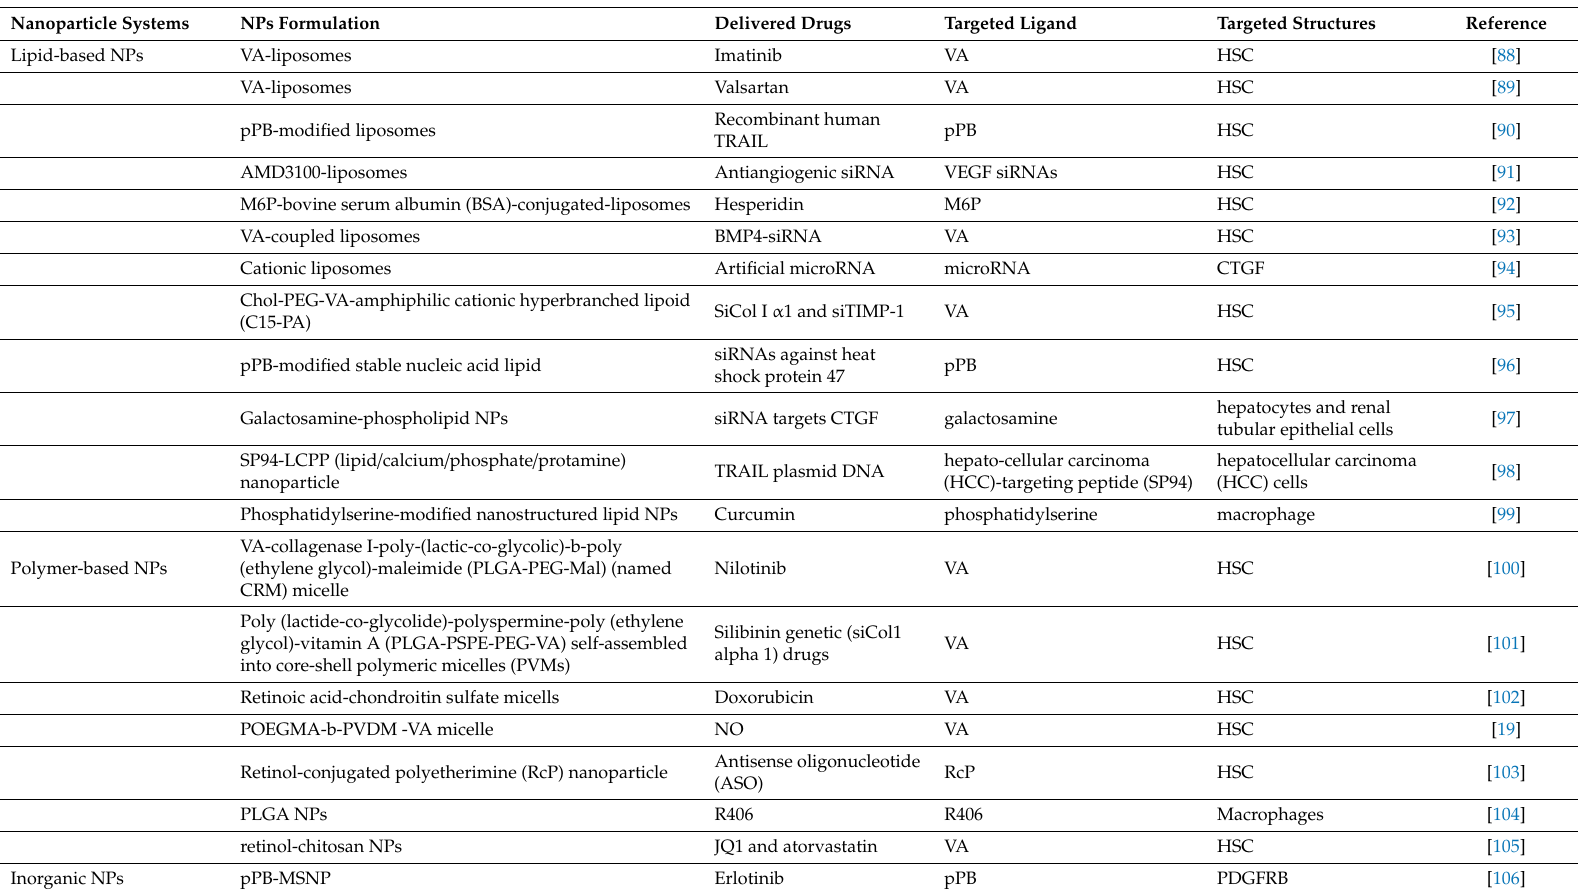
Table 2. NPs used in active targeting therapy of liver